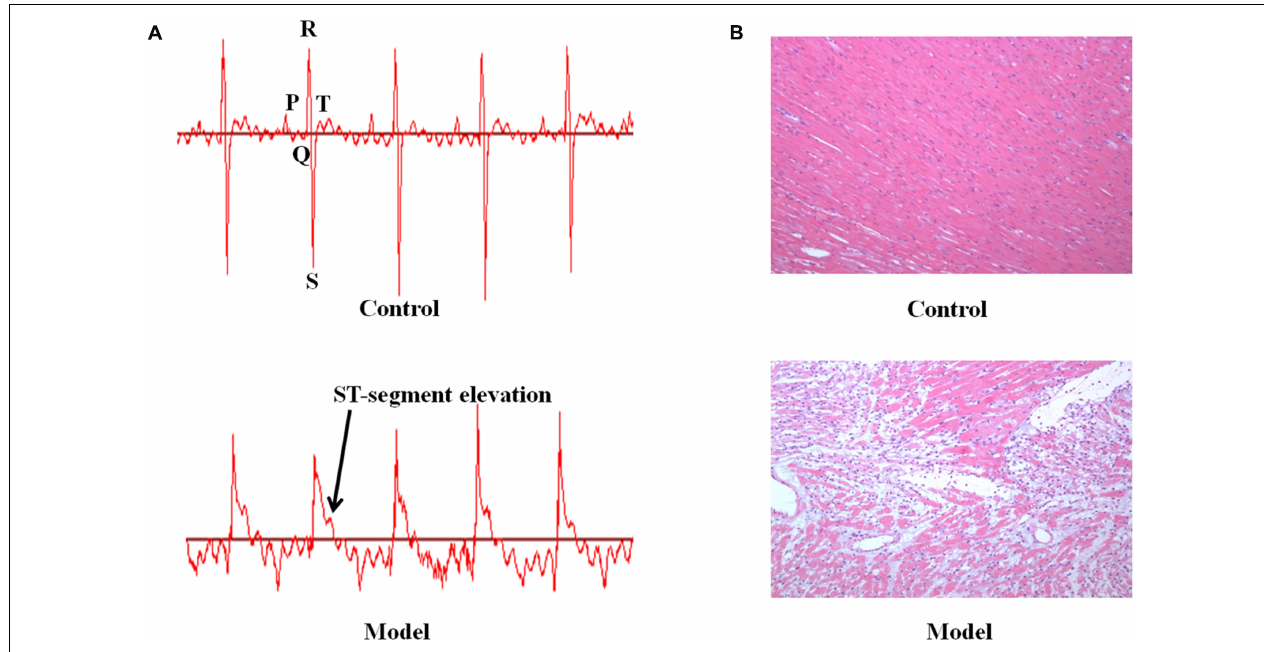
FIGURE 1 | The ISO-induced AMI rats display ST-segment elevation and myocardium pathological change. (A) The representative electrocardiogram in the control and model groups. (B) The micrographs of myocardium for the experiment animals (HE, Original 100 × ).